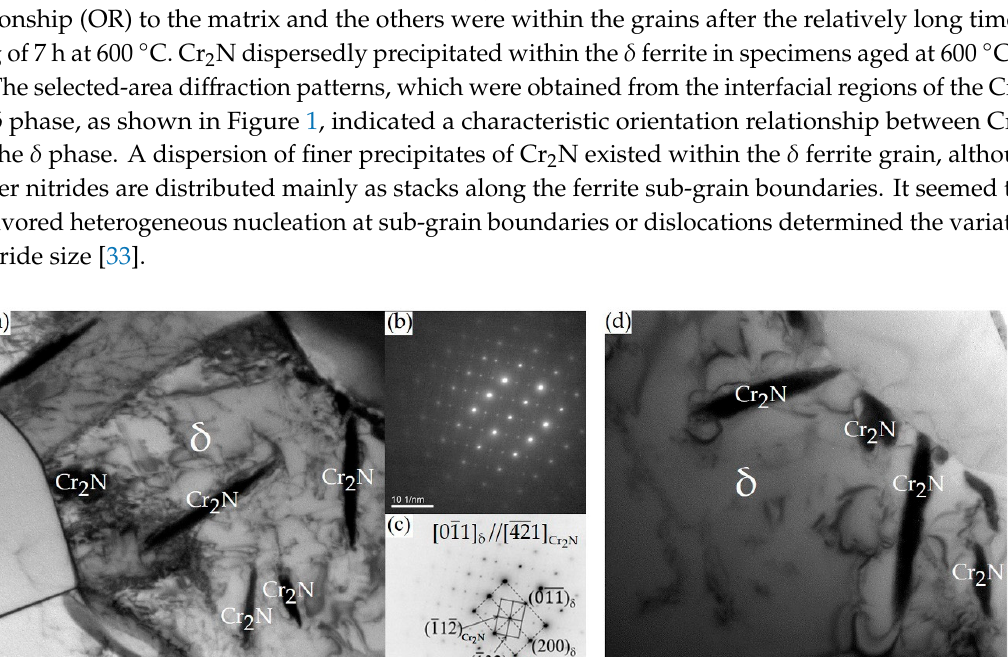
(cid:12) (cid:12)(cid:12) (cid:104) (cid:105) (cid:105) (cid:12)(cid:104) (cid:12) (cid:12) ∥ [4 (cid:3364) 2 (cid:3364) 1] ; ( c ) (cid:12) (cid:12) 011 421 ; δ Cr 2 N δ Cr 2 N